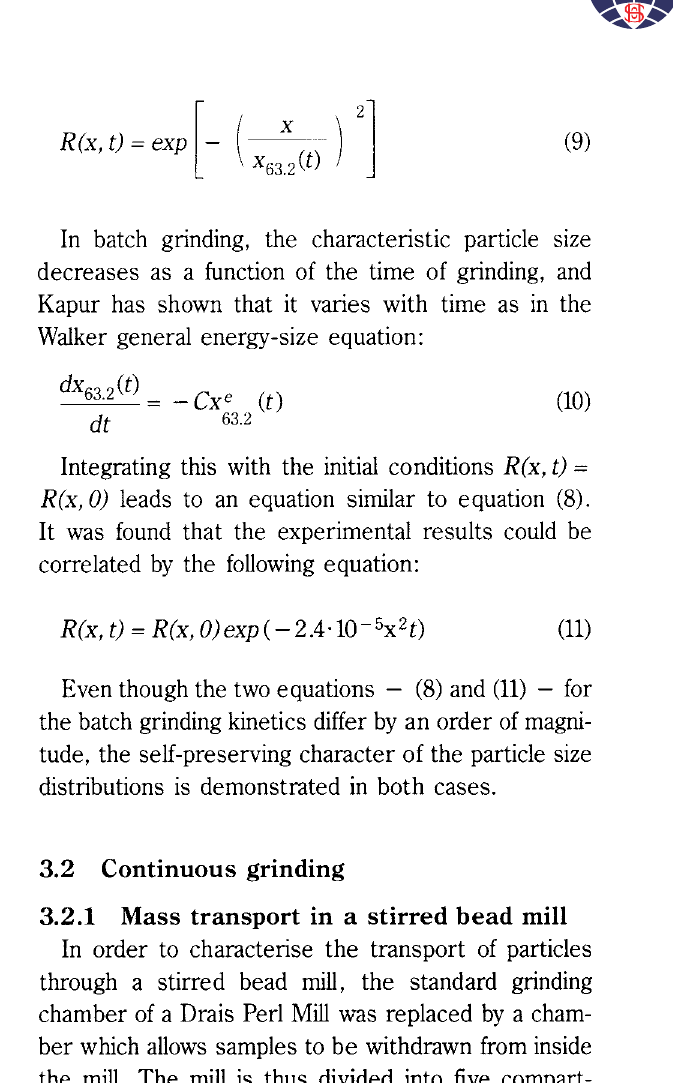
Fig. 5 Self-similar particle size distribution (stirred bead mill)